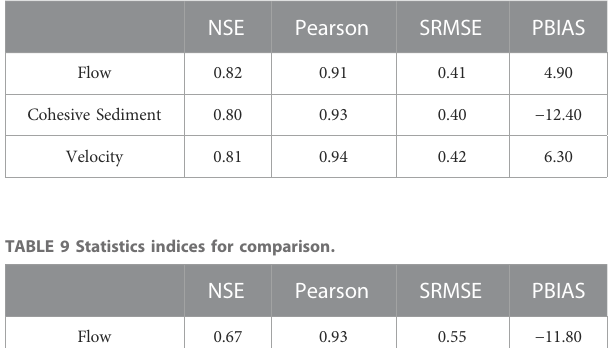
TABLE 8 Statistics indices for comparison.